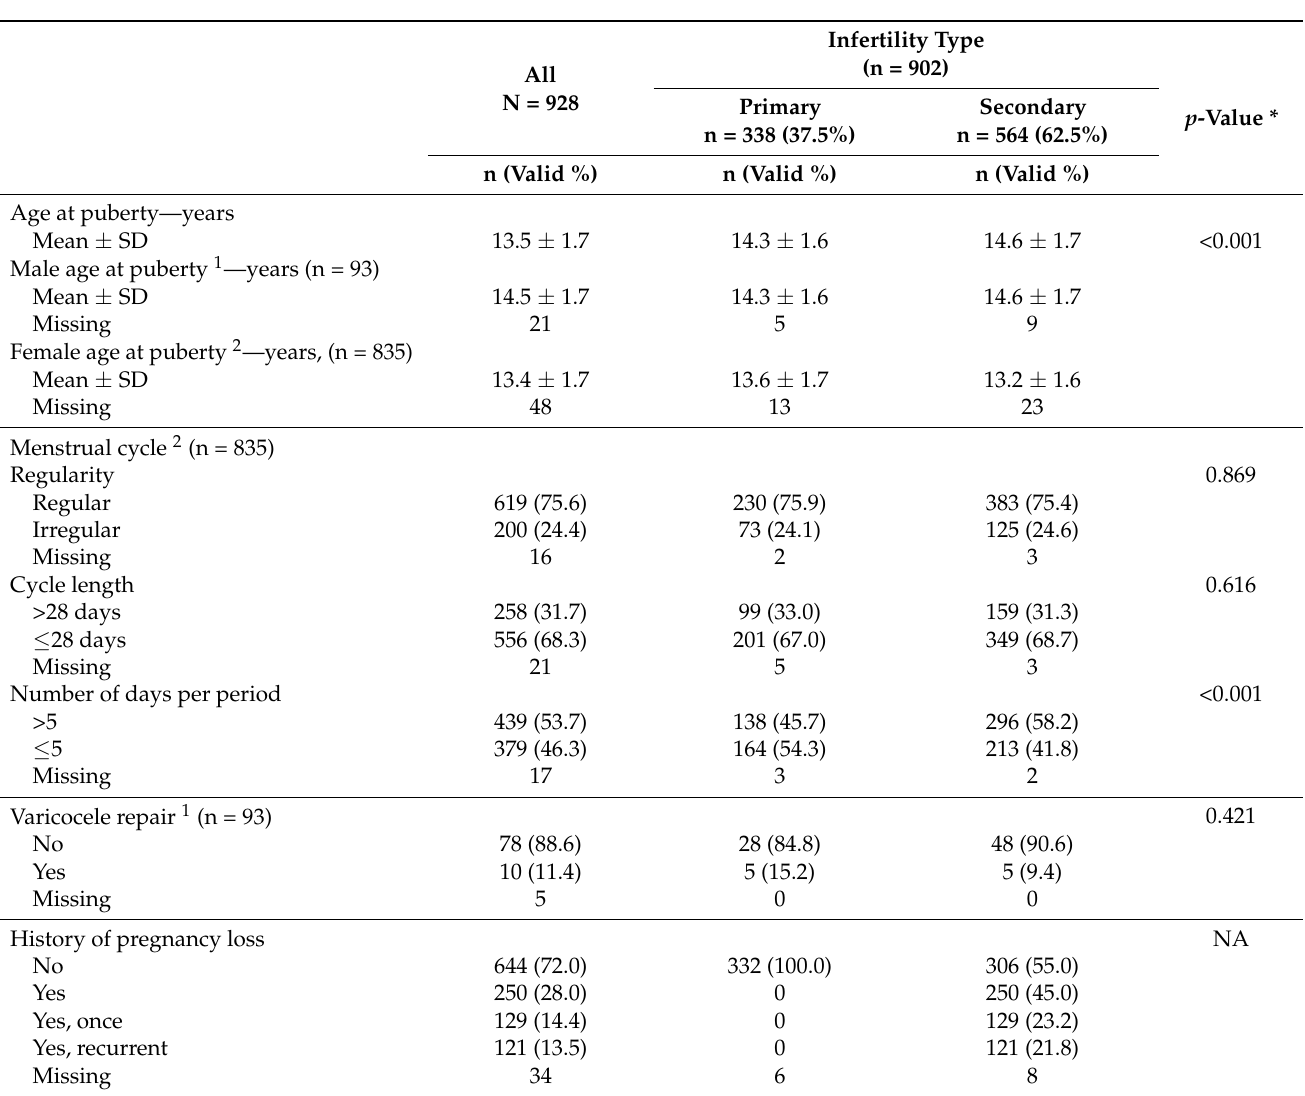
Table 4. Fertility-related characteristics of fertility clinic attendees, and the distribution between primary and secondary infertility. Infertility Type (n = 902) All N = 928 *Primary Secondary p -Value n = 338 (37.5%) n = 564